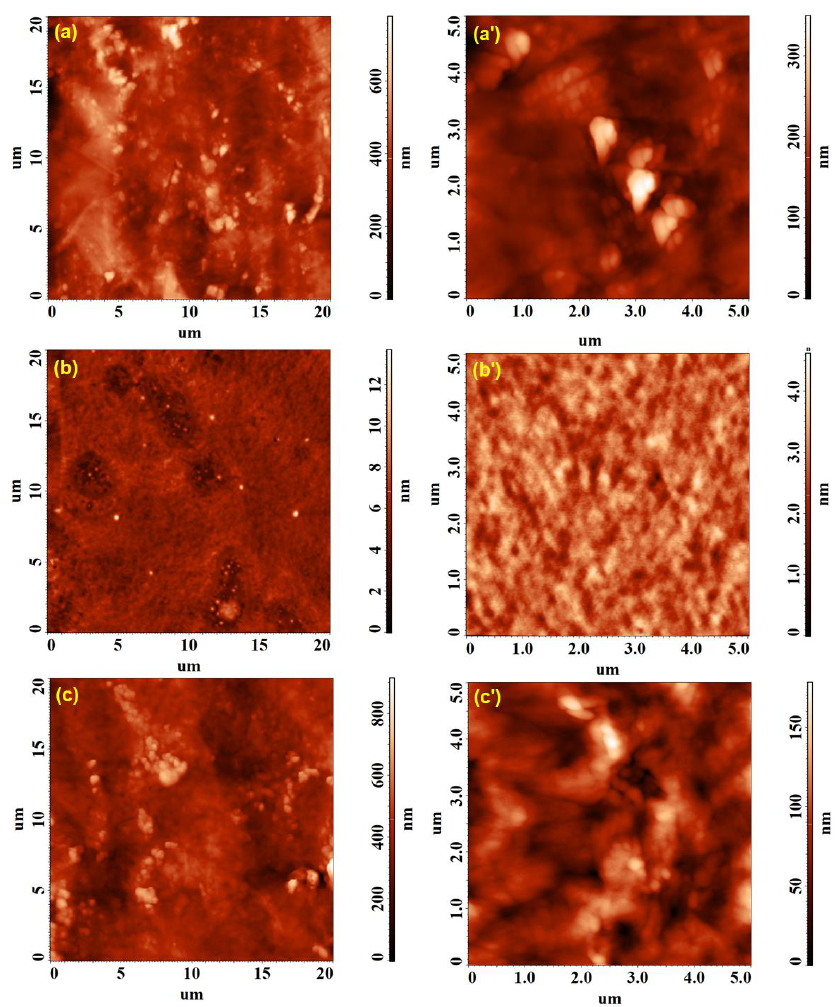
Figure 8. AFM topographical images collected on 20 × 20 µm 2 and 5 × 5 µm 2 for pristine HPMC ( a , a ’ ), PVP ( b , b ′ ) and HPMC/PVP ( c , c ′ ) samples.